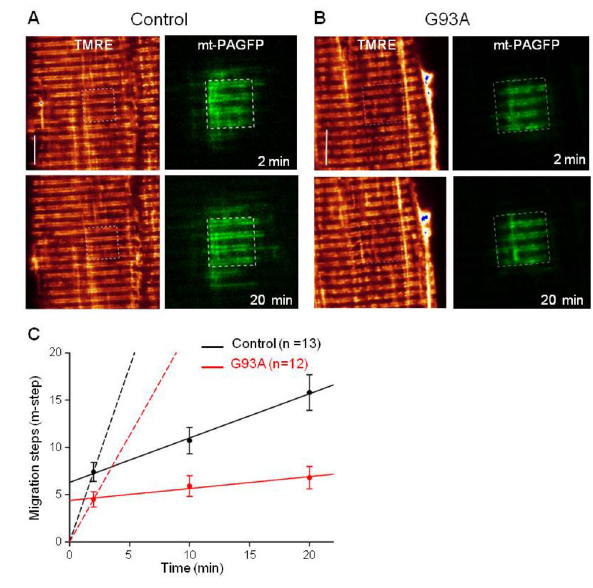
Figure 2. Migration of mt-PAGFP out of the photoactivation region of muscle fibers. Representative images of normal (control) ( A ) and G93A muscle fibers ( B ). The first image was taken 2 min after the photoactivation because it took a couple of minutes to reconfigure the confocal microscope system to conduct the simultaneous scan. The photoactivation region inside the fiber was marked with the box (white dashed line). Bar: 10 µm. ( C ) is the time course of mt- PAGFP migration. The linear regression was used to fit the data to evaluate the migration rate. Solid lines are the linear regression of the data after 2 minutes of the photoactivation. By assuming the migration step is zero at time zero, the linear regression was applied to determine the migration rate during the first 2 min (dashed line). The migration rates are listed in Table 1 .